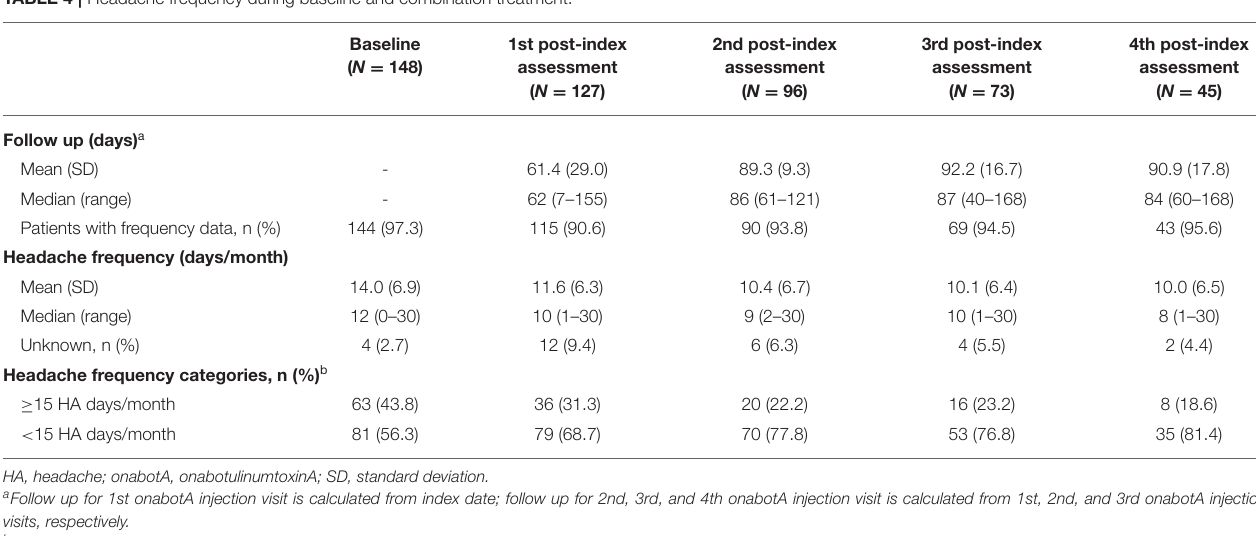
TABLE 4 | Headache frequency during baseline and combination treatment.